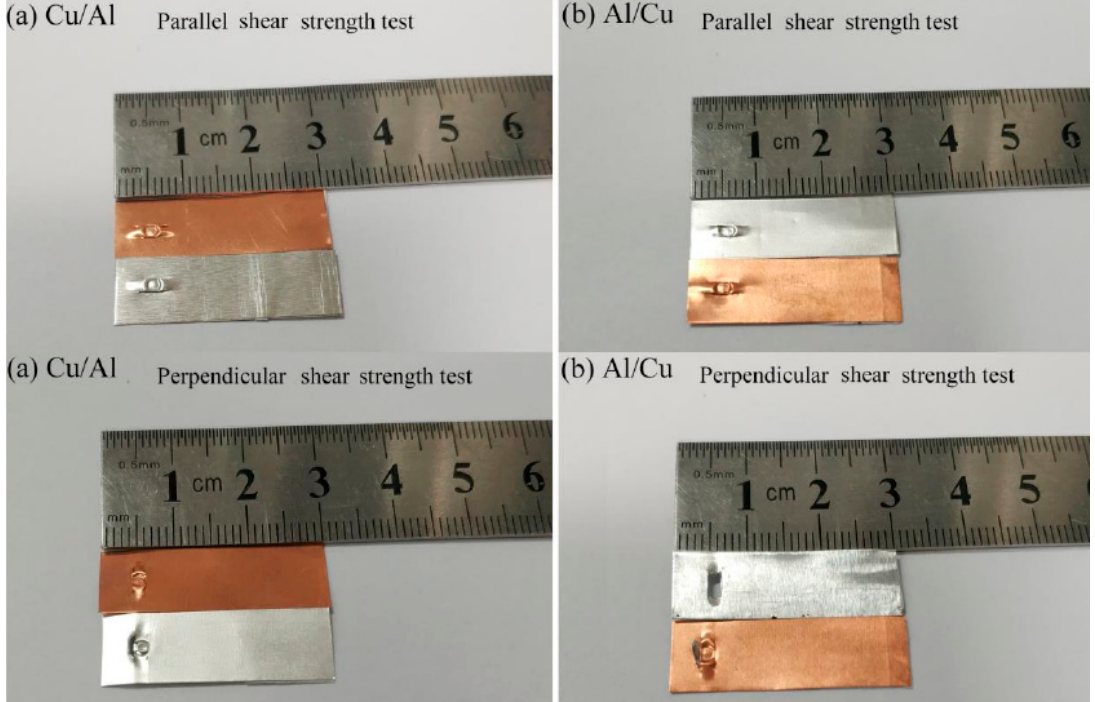
Figure 30. The failure modes of Cu/Al and Al/Cu by parallel and perpendicular shear strength test: ( a ) Cu/Al; ( b ) Al/Cu.